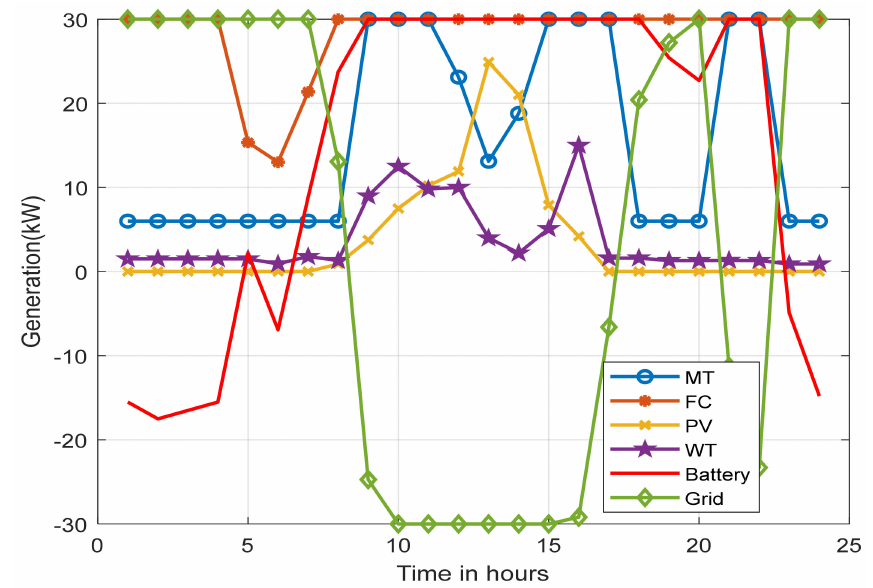
Figure 9. Power generation for Scenario